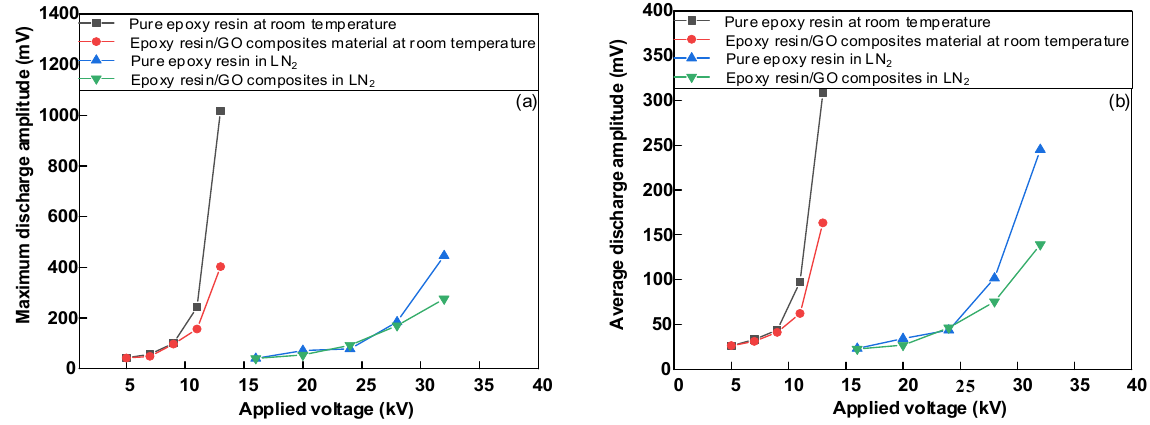
Figure 6. Variation characteristics of discharge repetition rate. ( a ) Variation characteristics of discharge repetition rate at room temperature; ( b ) Variation characteristics of discharge repetition rate at LN 2 .